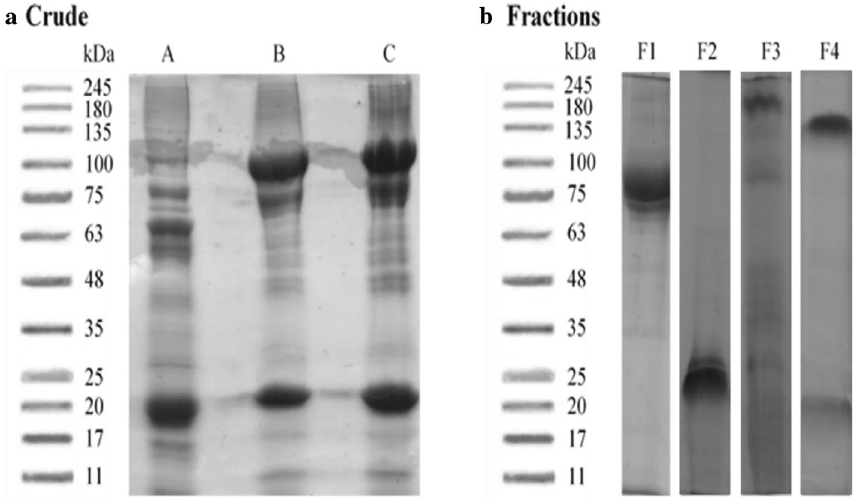
Figure 3. Protein profile for crude and fraction by 12% SDS PAGE from Sephadex G-25. ( a ) Crude mucus (AA) represents 1st replicate, (AB) represents 2nd replicate, (AC) represents 3rd replicate. ( b ) Protein fractions (F1) represents 1st fraction, (F2) represents 2nd fraction, (F3) represents 3rd fraction, (F4) represents 4th fraction. The figures are combination of different gels blot picture, and the original picture are shown in (Supplementary Figs. S1, S2, S3, S4,